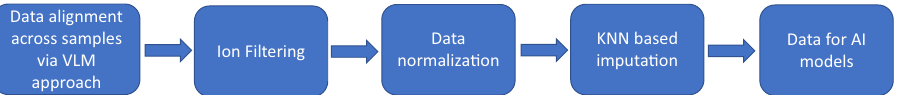
Figure 3. Data processing pipeline. The data preprocessing pipeline used to render the data amenable to AI modeling is depicted here (details are given in the text).